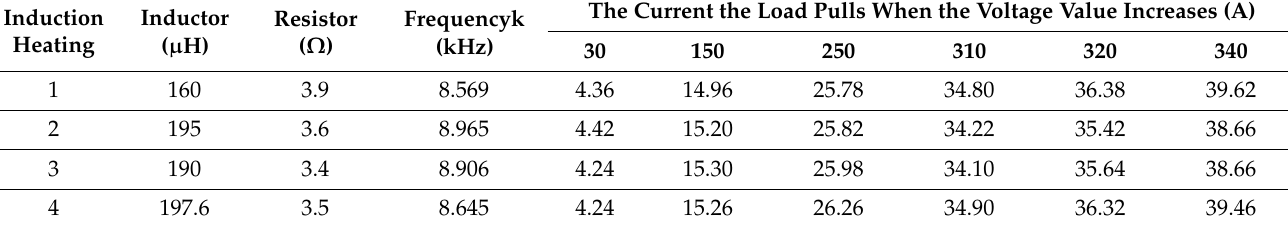
Table 1. Changes in the current when the voltage of the induction heating apparatus is increased when using 4 induction heating